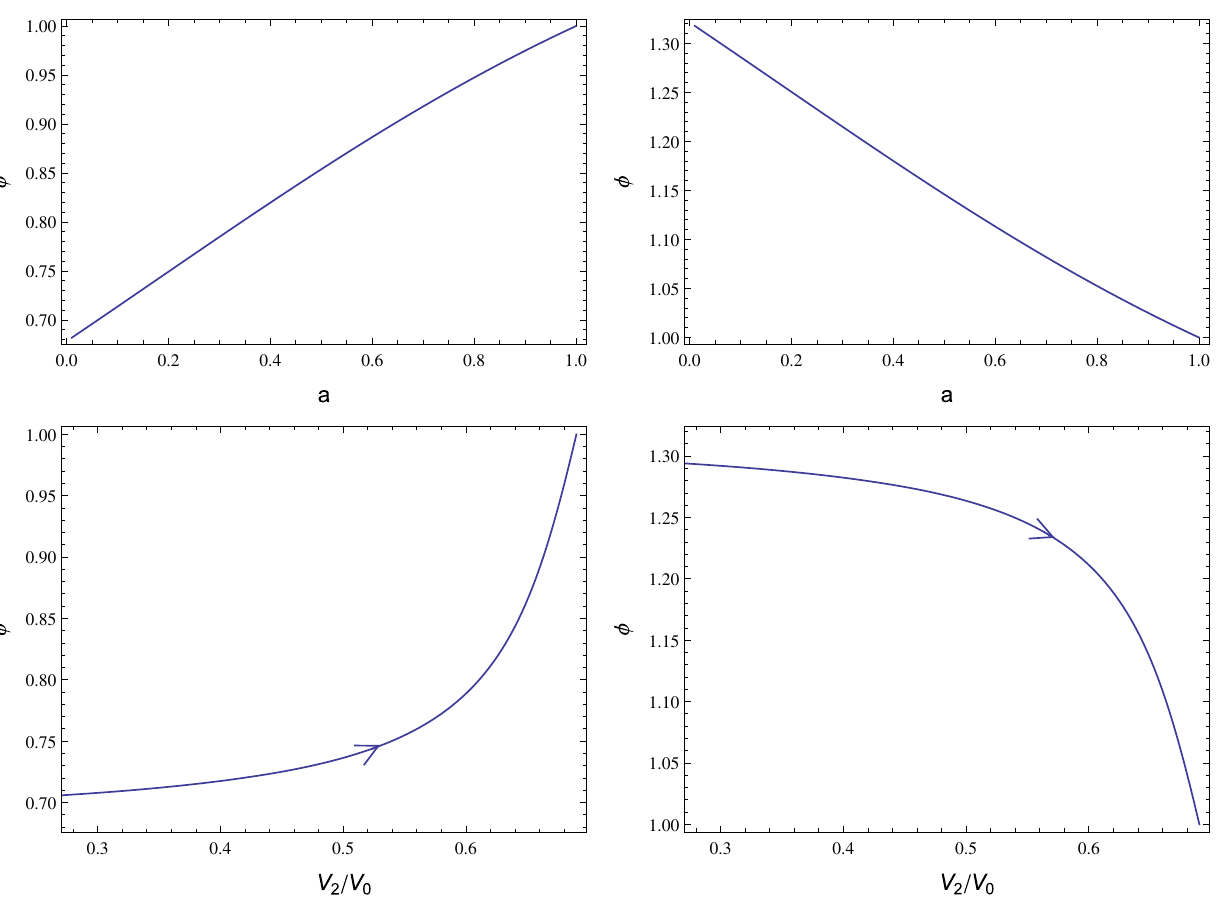
field φ and the scale factor a , and the relation between the phantom field φ and the potential V 2 / V 0 . The arrows indicate the evolutional direction of the potential. We have assumed α = 0 . 7 and β = − 0 . 02 numerically Table 1 The priors of different parameters used in the posterior